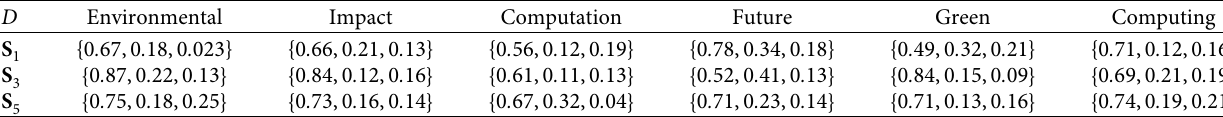
Table 1: A single value for neutrosophic set N